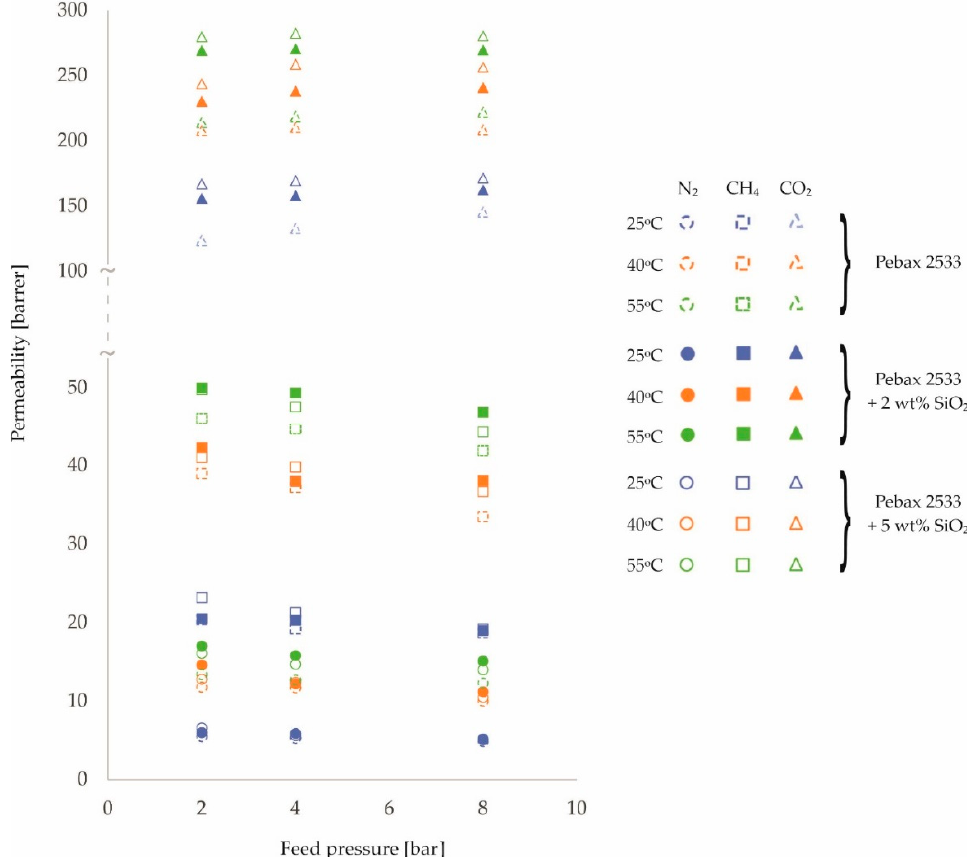
Figure 1. Change in permeability values of homogeneous membrane and heterogeneous membranes containing SiO 2 for different feed pressure and temperature values.